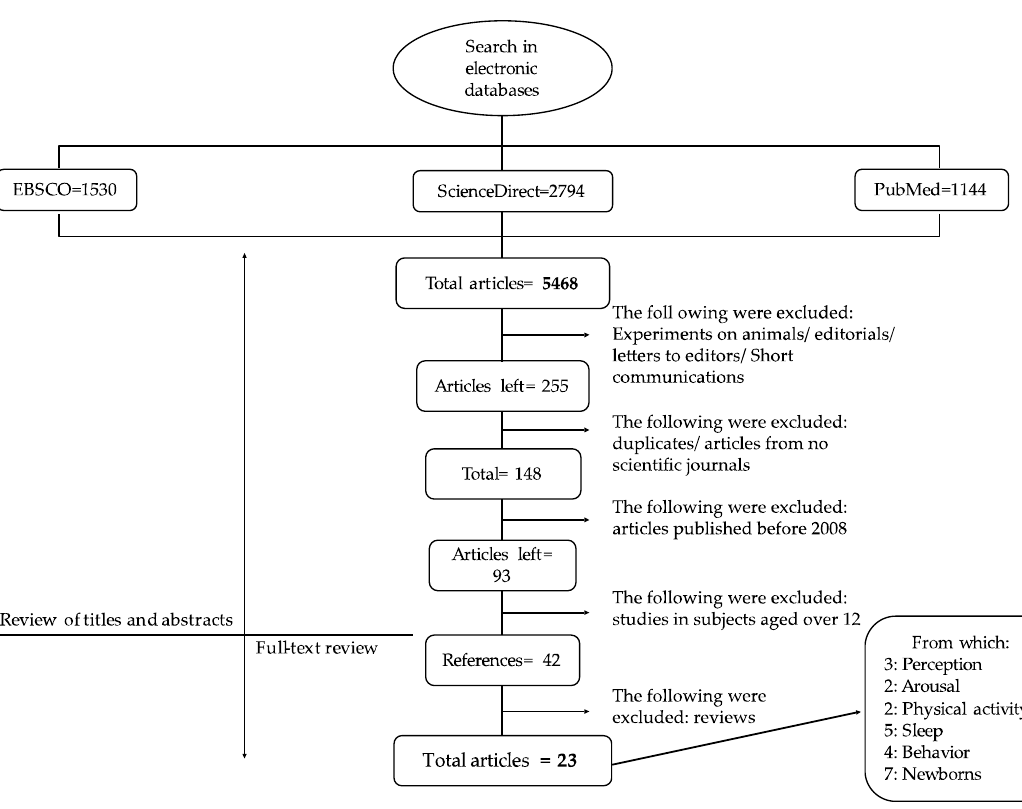
Figure 3. Process of systematic review of the